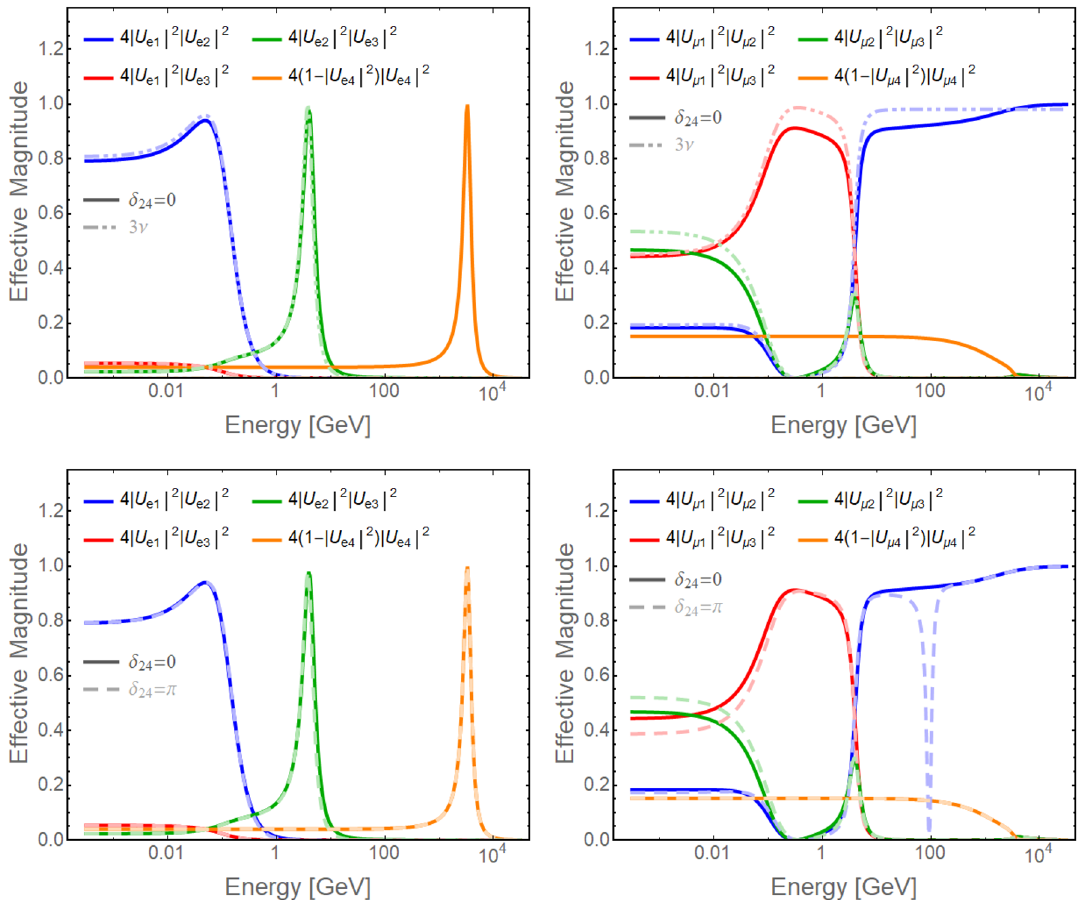
Figure 2 . Effective oscillation magnitudes associated with ∆ 21 , ∆ 31 , ∆ 32 , and ∆ 4 k (see equa- tion (3.1)) as a function of neutrino energy. The latter is taken as a combination of all three mass-squared difference terms involving the fourth mass state, which are approximately of equal frequency at this scale. Left: magnitudes associated with ν e disappearance probabilities. Right: magnitudes associated with ν µ disappearance probabilities. Top: comparison between 3 ν and a sterile neutrino scenario with δ 24 = 0 . Bottom: comparison between sterile neutrino scenarios with δ 24 set to either 0 or π . All plots apply to neutrinos in normal ordering. The same parameters as in figure 1 were